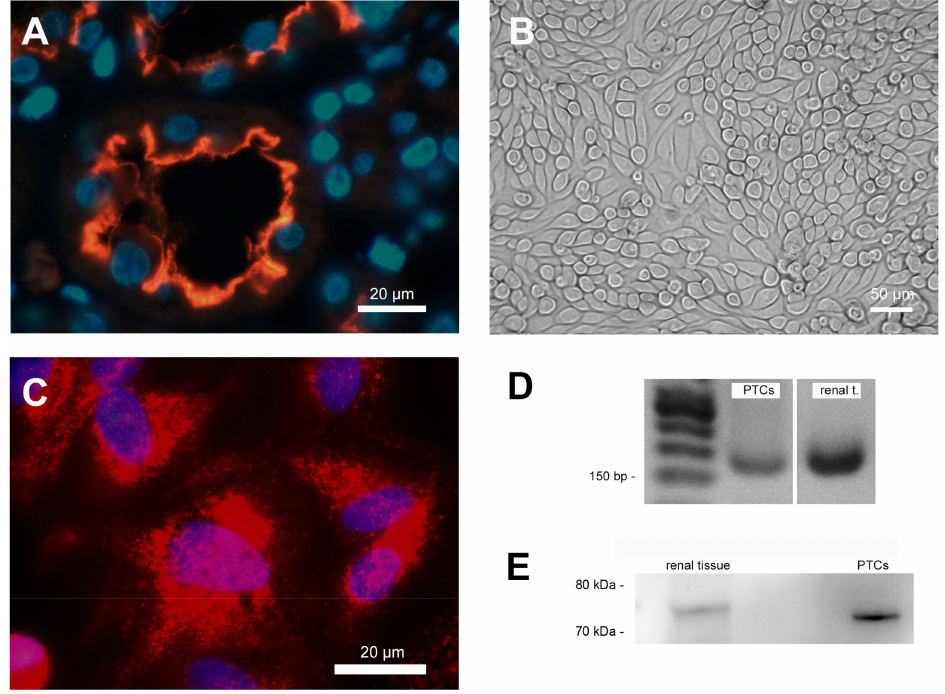
Figure 1. Cell characterization. ( A ) Immunofluorescence staining of human renal para ffi n-embedded tissue sections showing sodium-glucose co-transporter 2 (SGLT-2) expression on the apical cell membrane in the proximal tubular nephron. Nuclei were counterstained with 4,6-diamino-2-phenylindole (DAPI; blue). ( B ) Characteristic phase contrast microscopy of confluent PTCs cultured in standard cell culture. ( C ) Immunofluorescence staining of SGLT-2 expression in cultured PTCs. Nuclei were counterstained with DAPI (blue). ( D ) Proof of SGLT-2 mRNA expression in cultured PTCs and RNA from human renal tissue extracts using PCR. ( E ) Proof of SGLT-2 protein expression in cultured PTCs and protein from human renal tissue extracts using western